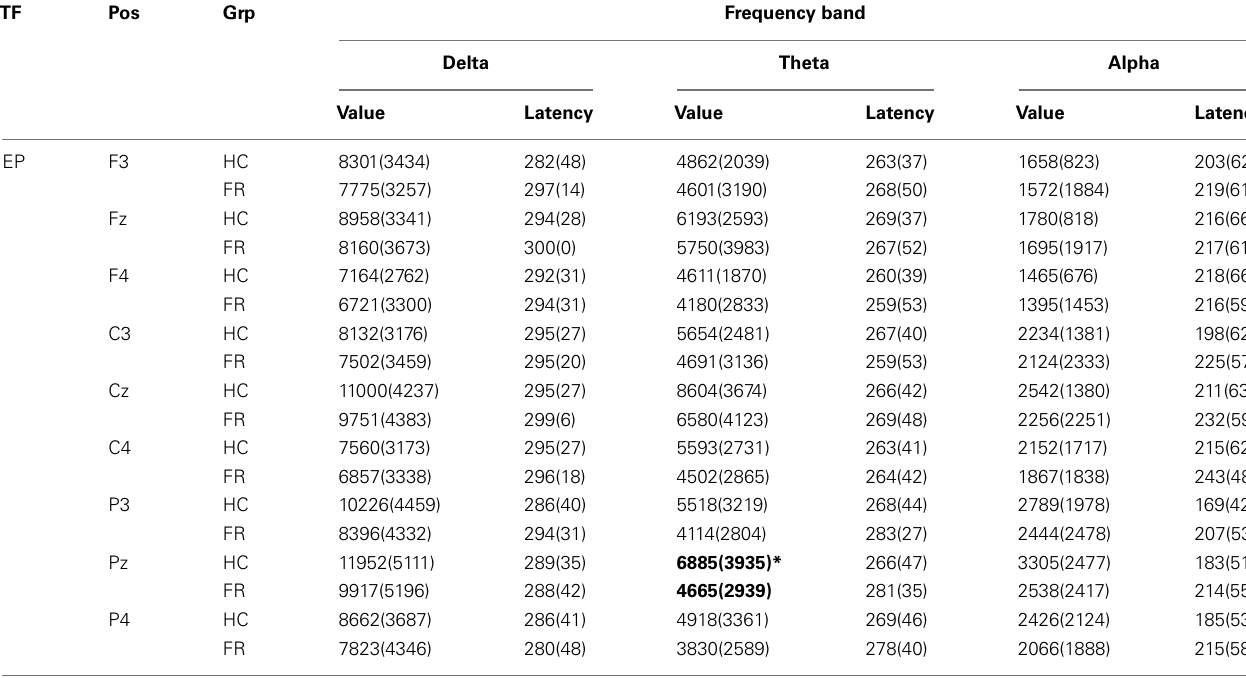
TableA2 | Means and SD (in parentheses) for time–frequency decomposition measures. Time range